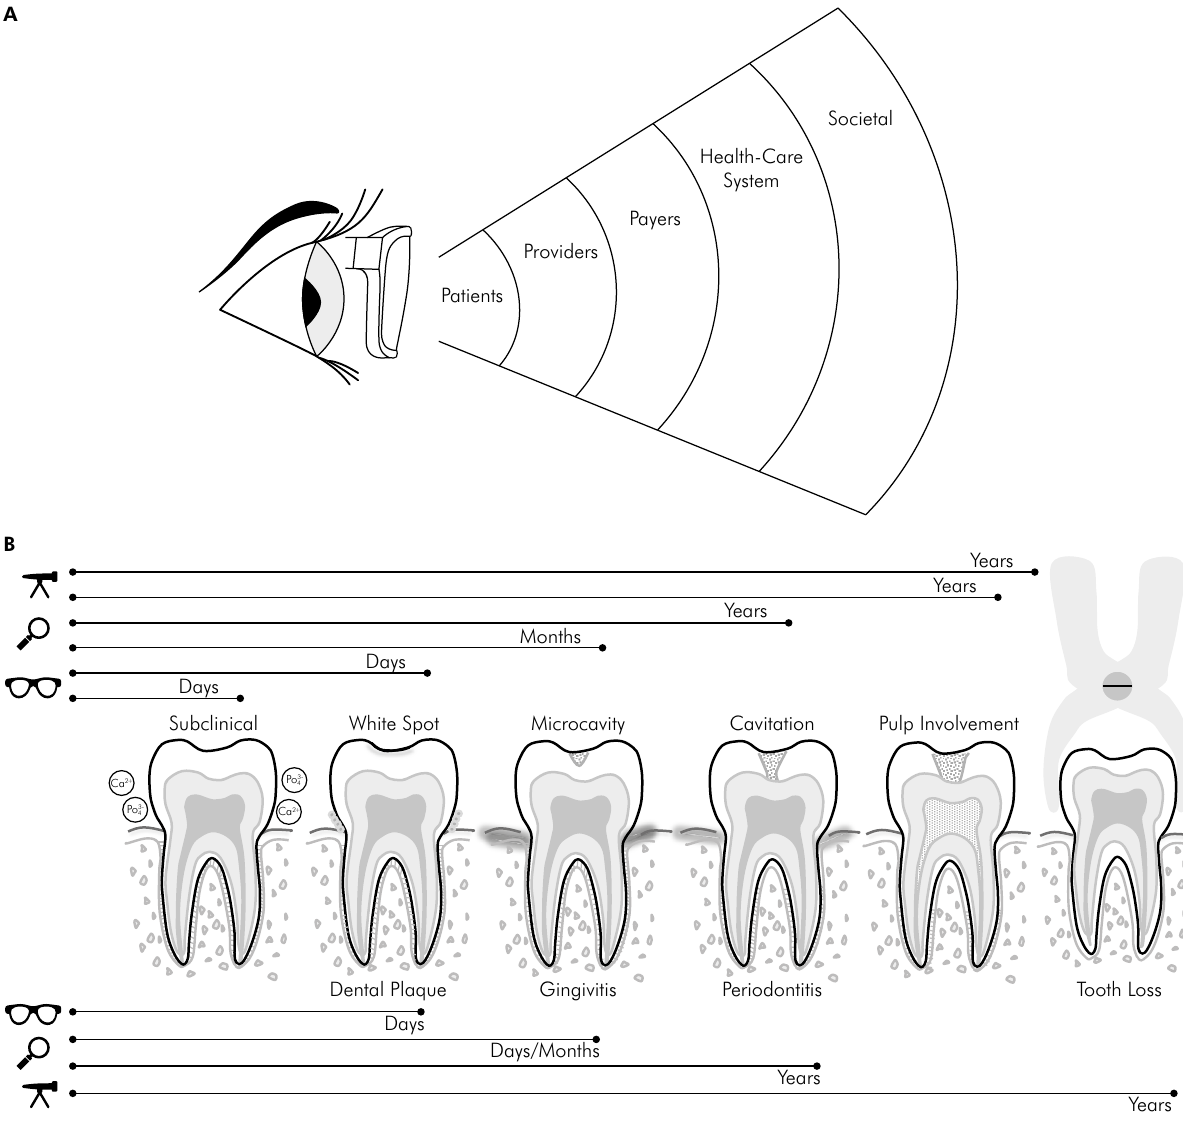
Figure 1. (a) Different perspectives of an economic evaluation. (b) Effect of time-horizon on possible health effects to be